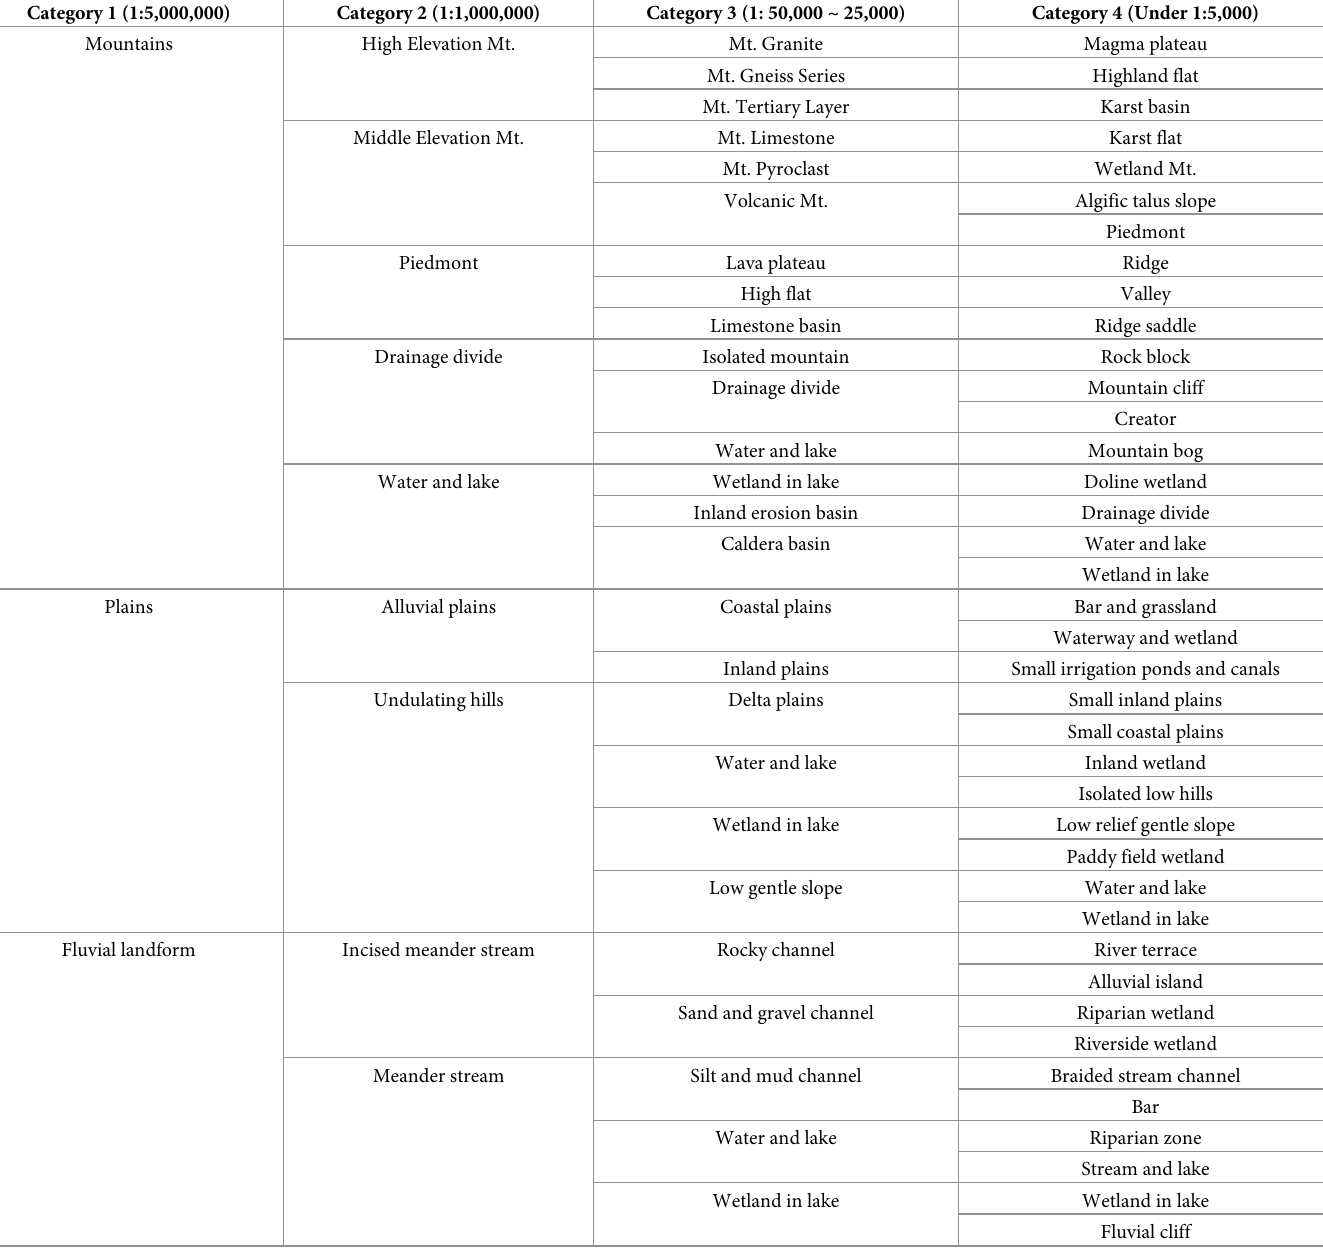
Table 2. Hierarchical landform classifications by